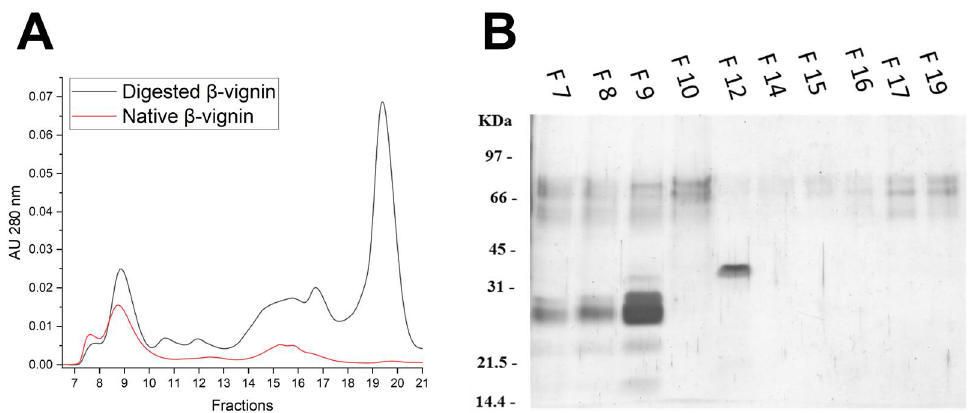
Figure 8. Non-denaturing and denaturing analysis of native and digested β -vignin. Panel ( A ): Su- perdex S75 10/300 column GL (30 cm × 10 mm) SEC of the native protein (red line) and of the digested protein (black line). For each run, 50 µ g of β -vignin (0.5 mg/mL) was loaded. Panel ( B ): SDS-PAGE of the SEC eluted fractions from the digested β -vignin. The gel was silver stained. To further characterize the products of proteolytic processes, RP-HPLC was per- formed to compare the native and the 30 h digested β-vignin (Figure 9).